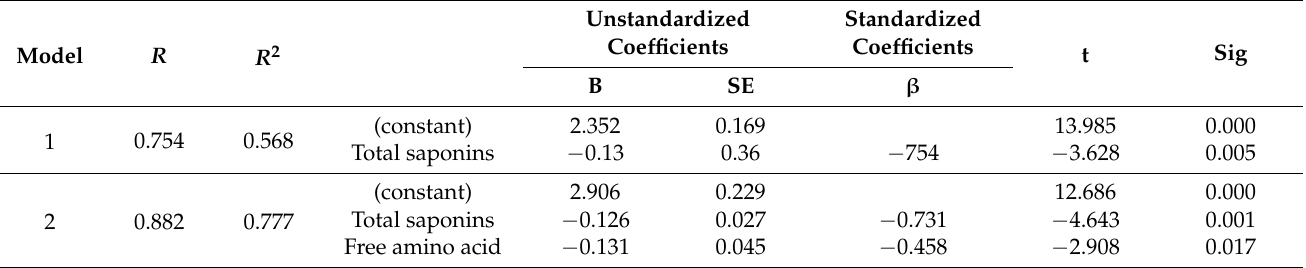
Table 5. Results of multiple stepwise regression